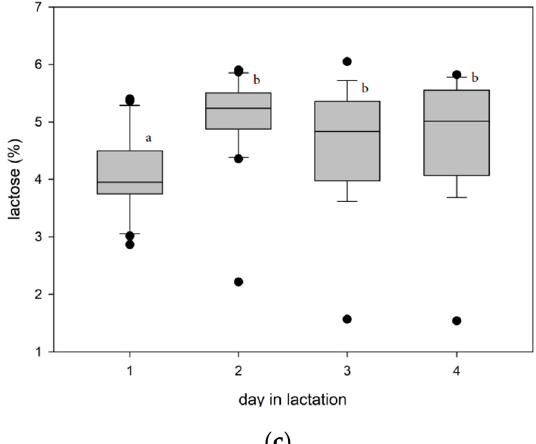
Figure 1. ( a ) Boxplot of fat concentration in alpaca colostrum during four days postpartum, significant differences between the days are marked with different indices. ( b ) Boxplot of protein concentration in alpaca colostrum during four days postpartum, significant differences between the days are marked with different indices. ( c ) Boxplot of lactose concentration in alpaca colostrum during four days postpartum, significant differences between the days are marked with different indices. Table 2. Percentages of fat, protein, and lactose in alpaca colostrum during the four days postpartum, data are provided as median (1st quartile/3rd quartile); significant differences between the days are marked with different indices. Colostrum